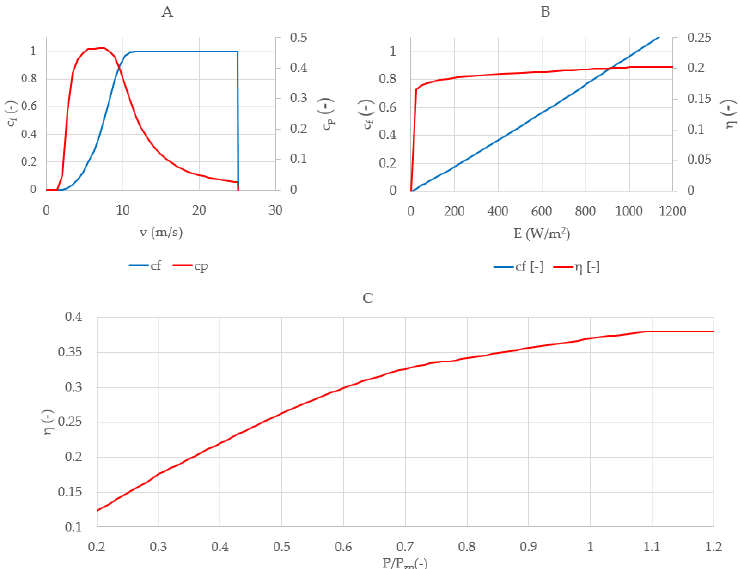
Figure 6. Characteristics of ( A ) wind turbines, ( B ) PV panels, and ( C ) gas